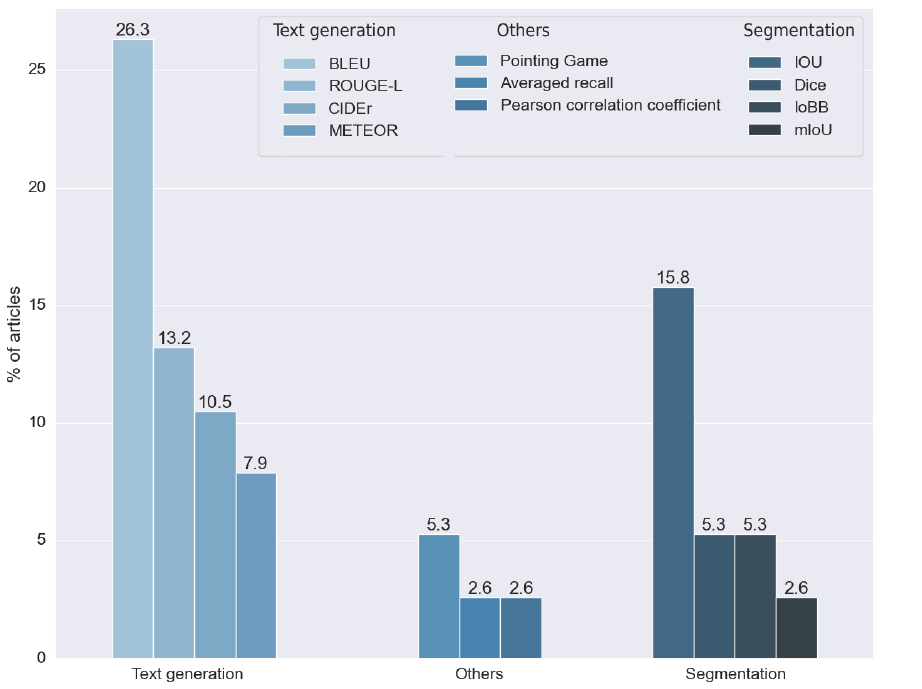
Figure 21. Metrics used for the evaluation results of RQ8, without considering the articles that did not indicate which metric was used. Vertical axis indicates the percentage of articles for each